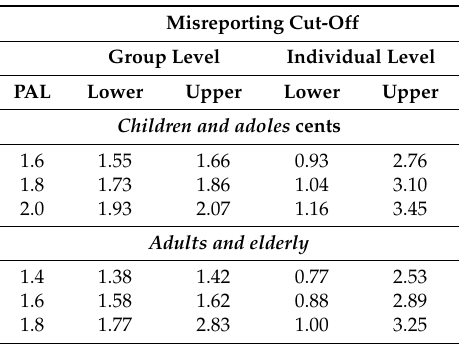
Table 1. Calculated misreporting cut-off at group and individual levels for the ANIBES